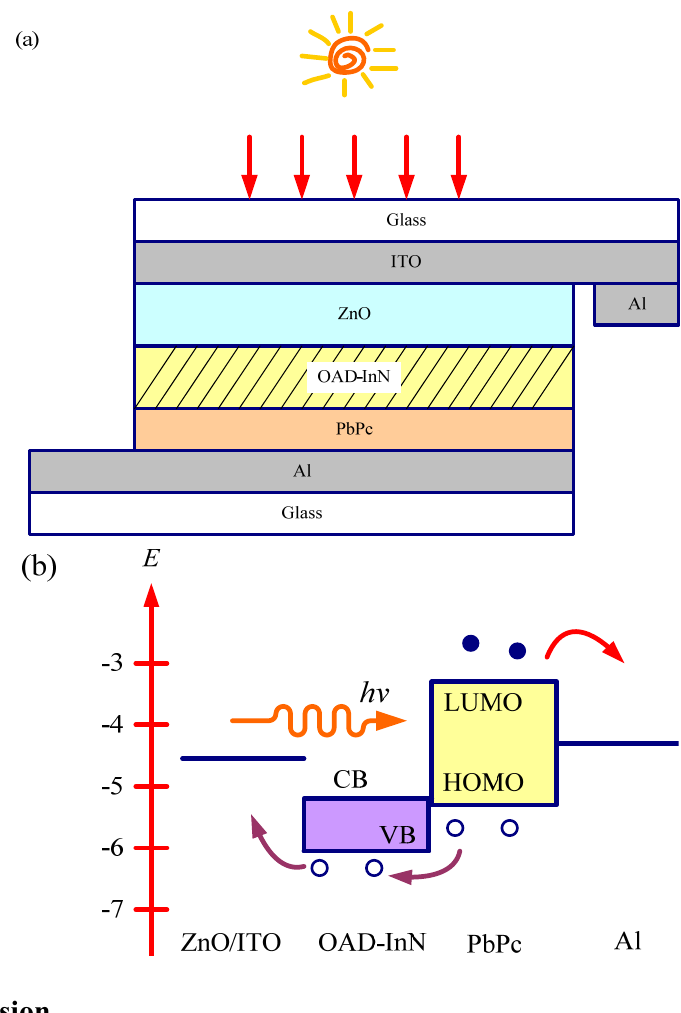
Figure 1. ( a ) Schematic cross-section of the completed structure. ( b ) Energy level diagram and mechanism of photocurrent generation in the solar cells with ZnO/OAD-InN/PbPc